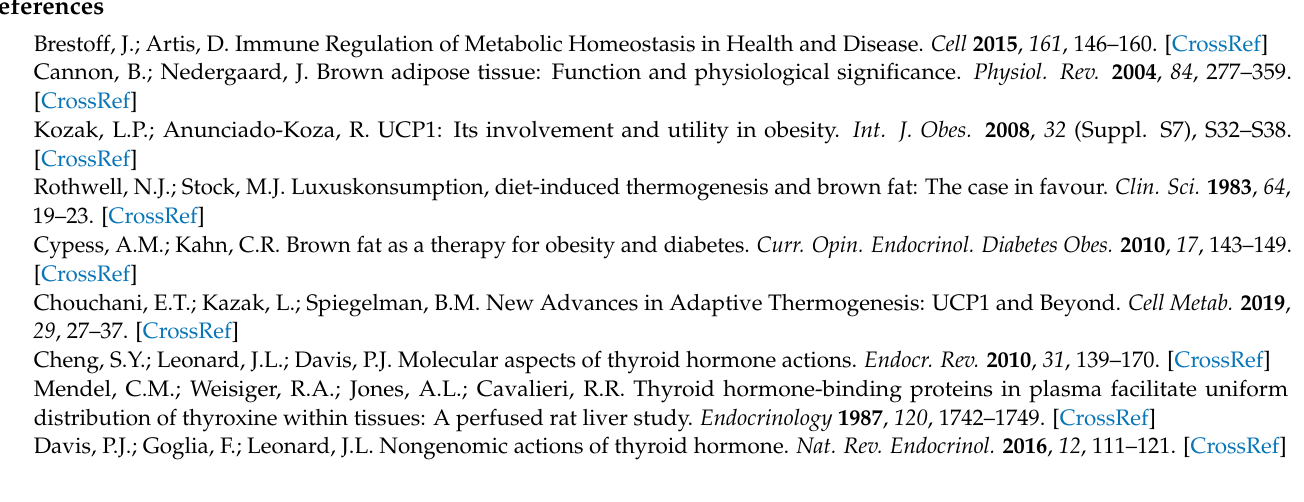
Figure S5: PLC inhibitors inhibit effects of T 3 on brown adipocytes. Figure S6: T 3 induces phosphory- lations of AMP kinase and acetyl-coA carboxylase, Supplemental